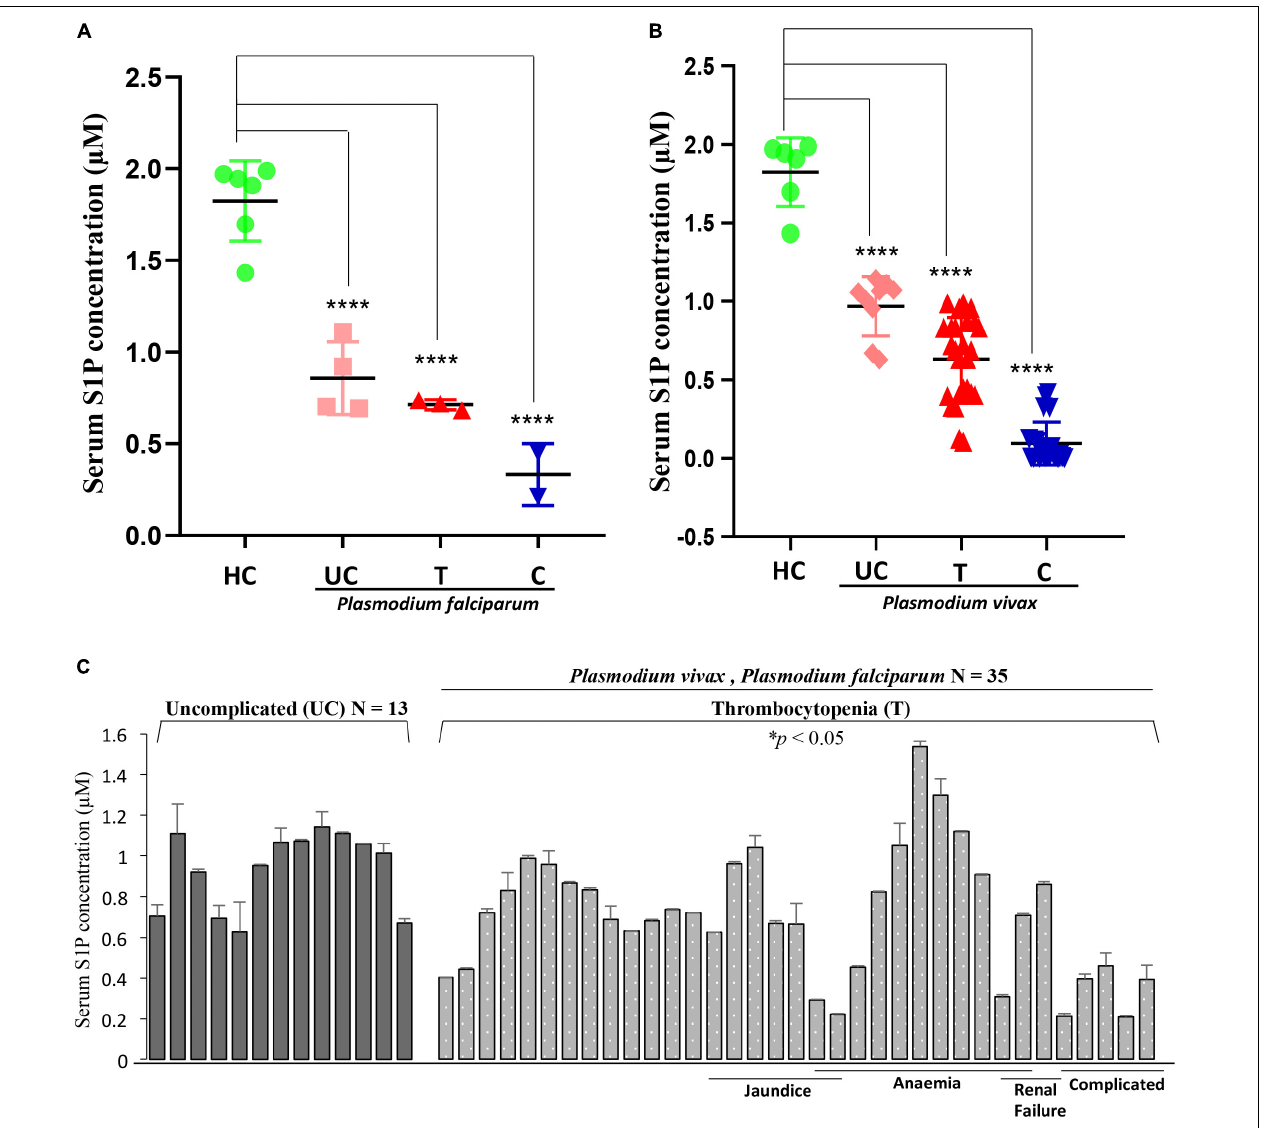
FIGURE 4 | Serum S1P level in P. falciparum - and P. vivax -infected malaria patients decreases compared to the healthy individuals. (A) The representative scatter plot displays S1P levels ( µ M) in uncomplicated (UC), thrombocytopenia (T), and complicated cases (C) of P. falciparum -infected serum samples ( N = 9) of malaria patients and healthy individuals ( N = 6). One-way ANOVA followed by Tukey’s post hoc test revealed significant differences with p -values: **** p < 0.0001, **** p < 0.0001, **** p < 0.0001 (comparison with healthy individuals). (B) The scatter plot depicts serum S1P levels ( µ M) in uncomplicated (UC), thrombocytopenia (T), and complicated cases (C) of P. vivax malaria patients ( N = 25) against the healthy individuals ( N = 6). One-way ANOVA followed by Tukey’s post hoc test revealed significant differences with p -values: **** p < 0.0001, **** p < 0.0001, **** p < 0.0001 (comparison with healthy individuals). (C) The graph denotes serum S1P levels (in µ M) in malaria patients with combined cases of thrombocytopenia (T) along with complicated (C), anemia (A), jaundice (J), and/or renal failure (RF) ( N = 35) irrespective of P. falciparum and/or P. vivax infection versus uncomplicated patients ( N = 13). The levels of S1P in all thrombocytopenia cases were found to be significantly lower than the uncomplicated malaria cases ( N = 13). Student’s t- test was performed; * p <